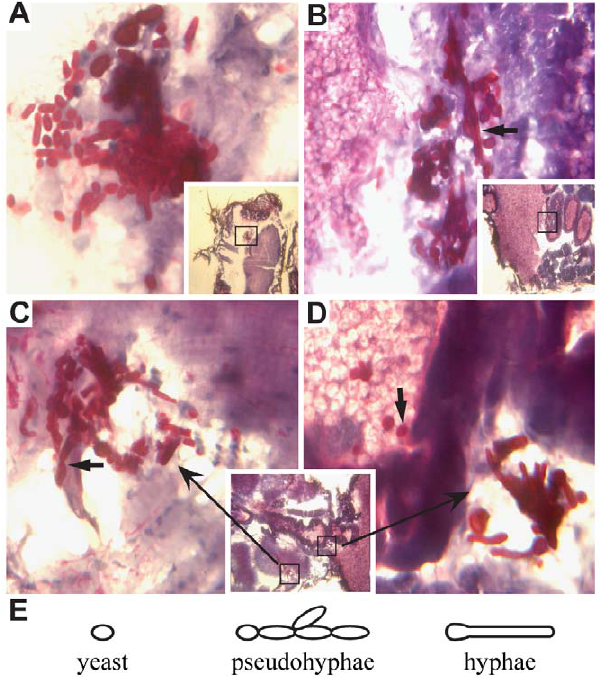
Figure 2. Wild-type C. albicans cells invade and colonize numerous sites and display multiple morphologies. Flies were injected with C. albicans (PMRCA18) and three days post-infection, histological sections of infected flies were prepared. A. Infection in the head. B. Infection in the abdomen. C and D. Infection at several sites within the thorax, including the muscles (C) and gut (D). The large photographs in each panel are higher magnification views of the insets as indicated. Yeast-like (thick arrow; panel D), pseudohyphal (thick arrow; panel C), and hyphal cells (thick arrow; panel B) are observed in all tissues. E. Schematic depiction of yeast-like, pseudohyphal, and hyphal morphological forms of C. albicans .